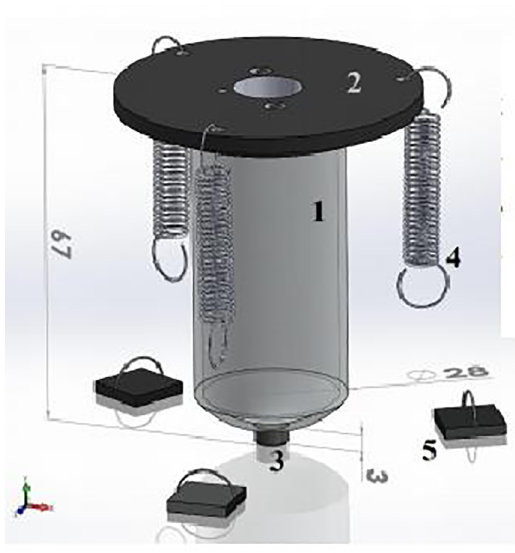
Figure 2. Schematic design of portable cell. 1- Cell body, 2- Cover, 3- O'ring, 4- Fixing springs, 5- Velcro feets. Dimensions in mm.